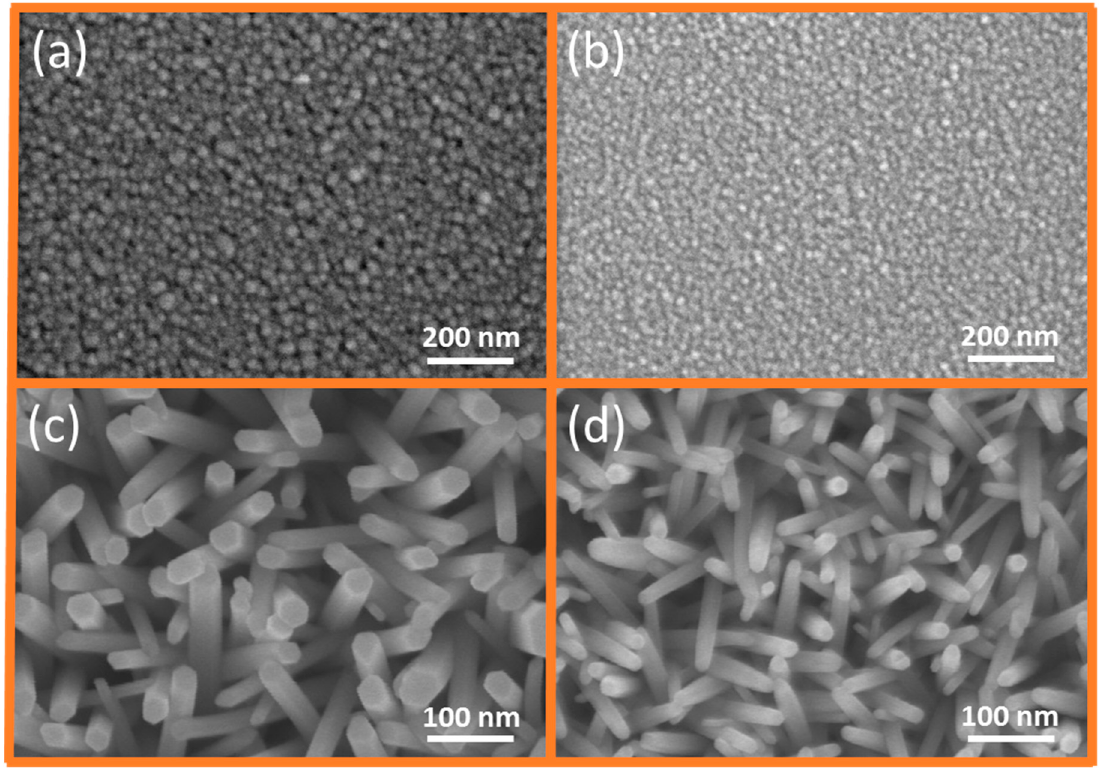
Figure 1. SEM images of: ( a ) undoped ZnO seeds; ( b ) Ga-doped ZnO seeds; ( c ) UZRs on undoped ZnO seeds; and ( d ) UZRs on Ga-doped ZnO seeds.